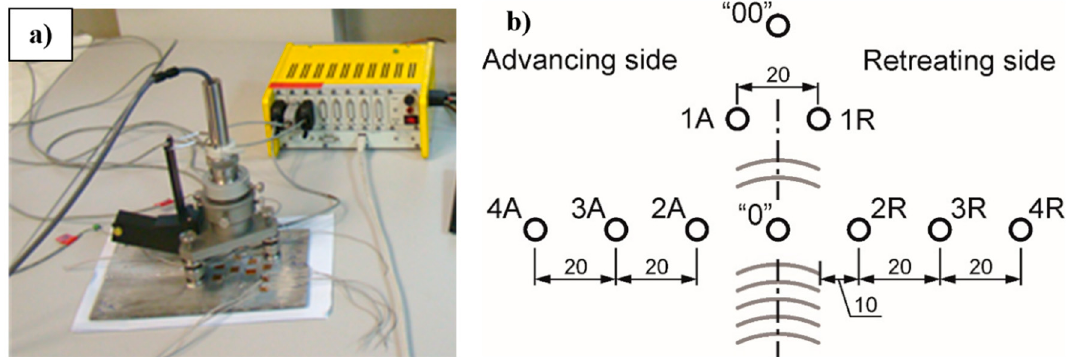
Figure 2. The view of a measuring stand with RS-200 system with the tensometer bridge ESAM Traveler Plus ( a ) and the location of numbered measuring points on the plate with friction stir welding (FSW) joint ( b ).